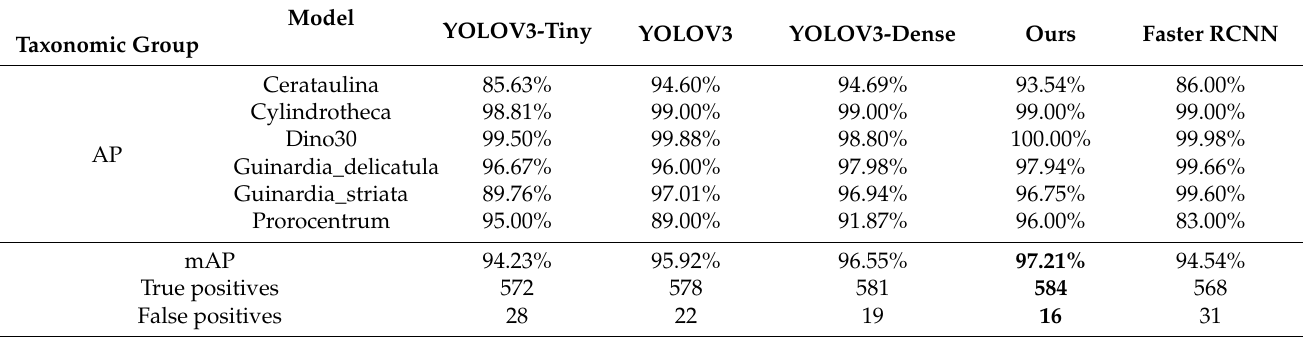
Table 4. Plankton detection performance of the proposed strategy and comparison models for the dataset in Table 2.